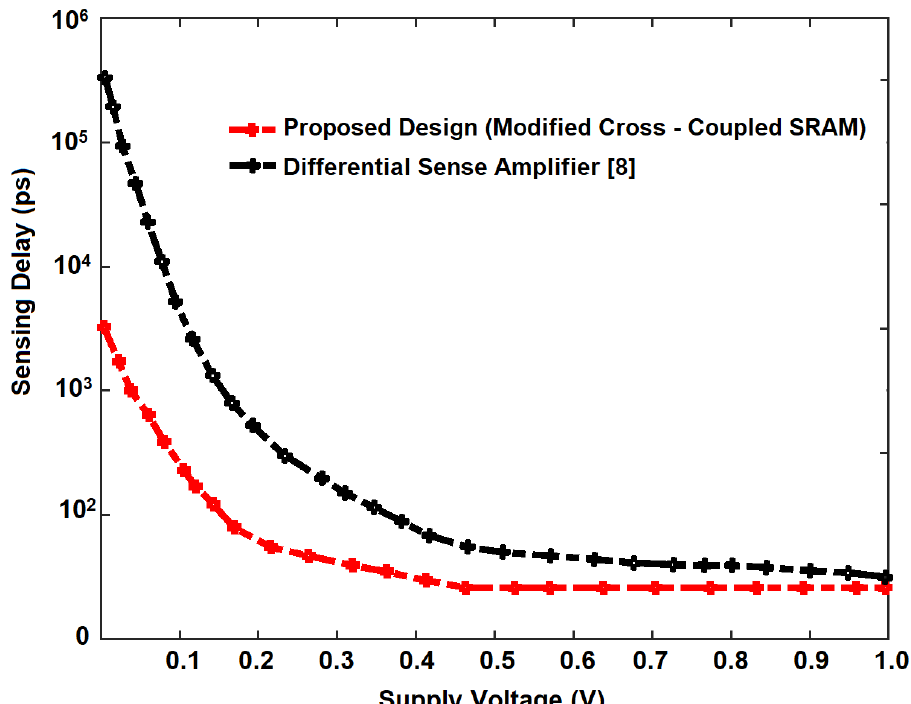
Figure 23. Sensing Delay of Proposed Sense Amplifier.